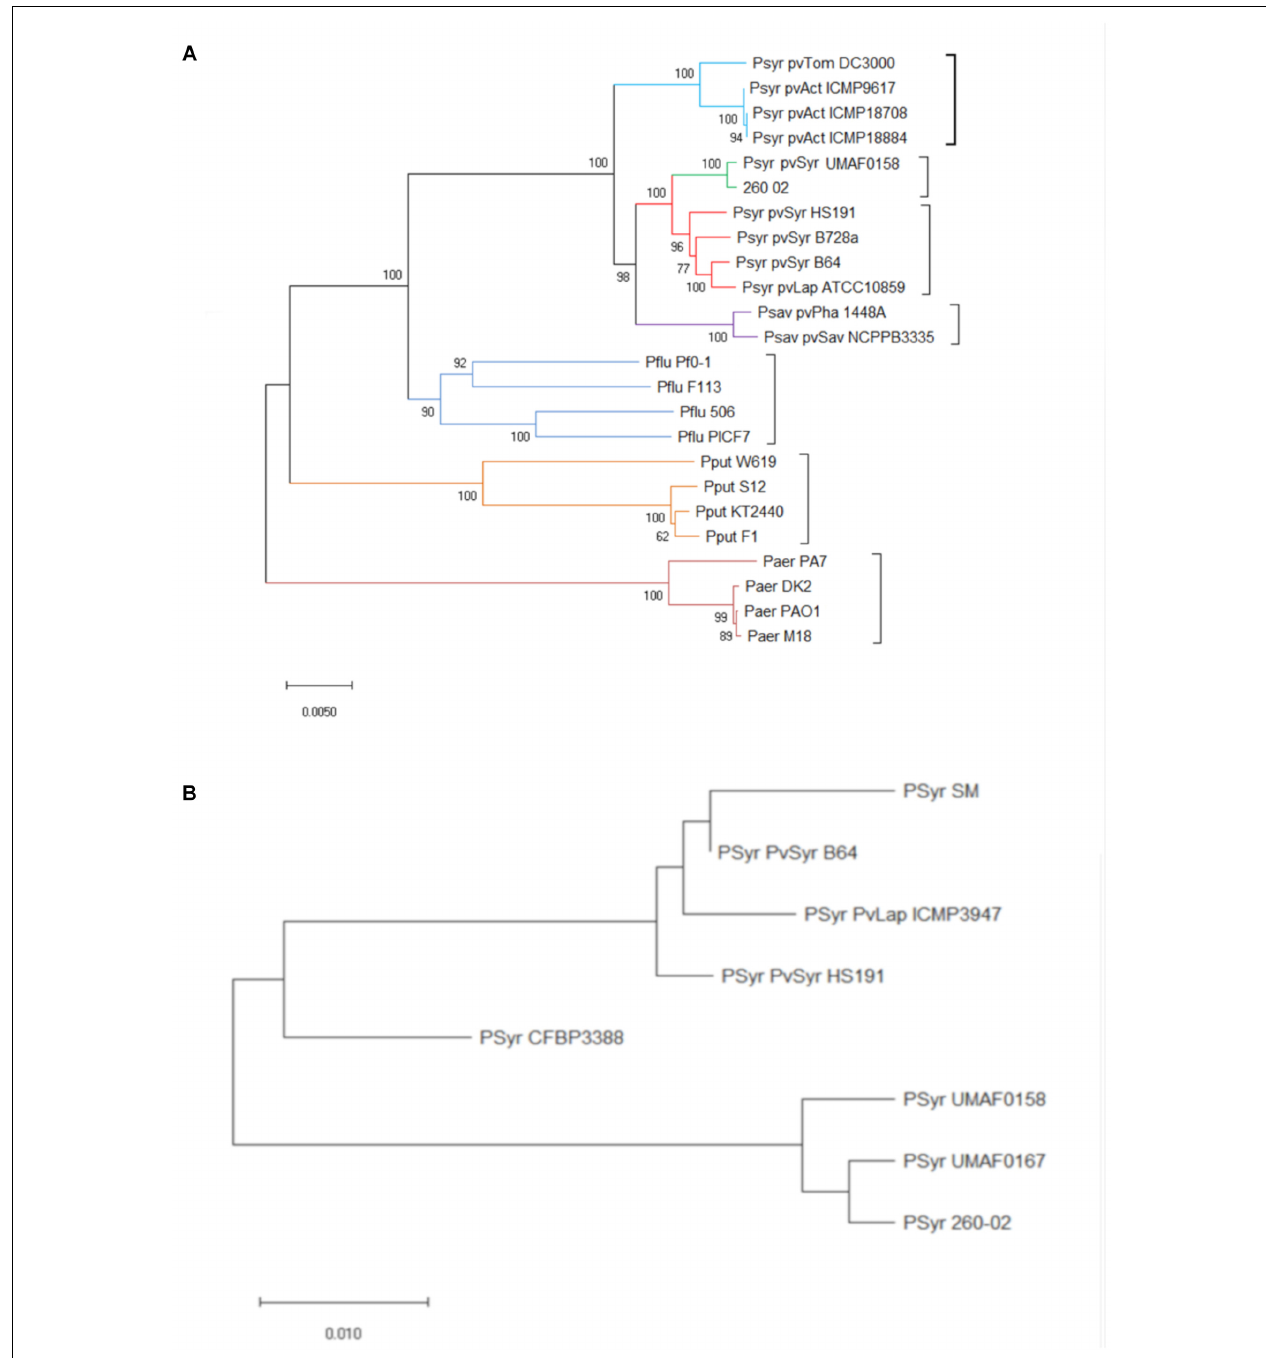
FIGURE 1 | Phylogenetic positions of strain 260-02 in relation to other P. syringae strains. Organisms included in the analysis are reported as follows: Psyr for Pseudomonas syringae ; Psav for Pseudomonas savastanoi ; Pflu for Pseudomonas fluorescens ; Paer for Pseudomonas aeruginosa ; Pput for Pseudomonas putida . Furthermore, for P. syringae and P. savastanoi , pathovars are defined as follows: pvTom for pathovar tomato ; pvSyr for pathovar syringae ; pvAct for pathovar actinidiae ; pvLap for pathovar lapsa ; pvPha for pathovar phaseolicola ; pvSav for pathovar savastanoi (A) Unrooted phylogenetic tree inferred from the gyrB / rpoD concatenated nucleotide sequence of strain 260-02 and the sequences obtained from GenBank ( Supplementary Table S1 ); minimum evolution method was carried out using the Jukes-Cantor model and bootstrap replicated 1,000 times. Names of strains are reported on the panel (B) Unrooted phylogenetic tree inferred from the predicted protein sequences coded by the mboE gene of strain 260-02 and the sequences obtained from GenBank ( Supplementary Table S1 ); The evolutionary history was inferred using the Minimum Evolution method. The tree is drawn to scale, with branch lengths in the same units as those of the evolutionary distances used to infer the phylogenetic tree. The evolutionary distances were computed using the Poisson correction method and are in the units of the number of amino acid substitutions per site. The tree was bootstrap replicated 1,000 times.